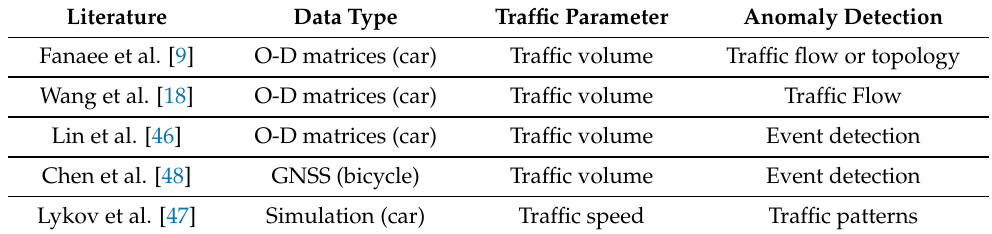
Table 4. Comparison of the proposed approach to other approaches for the traffic anomaly